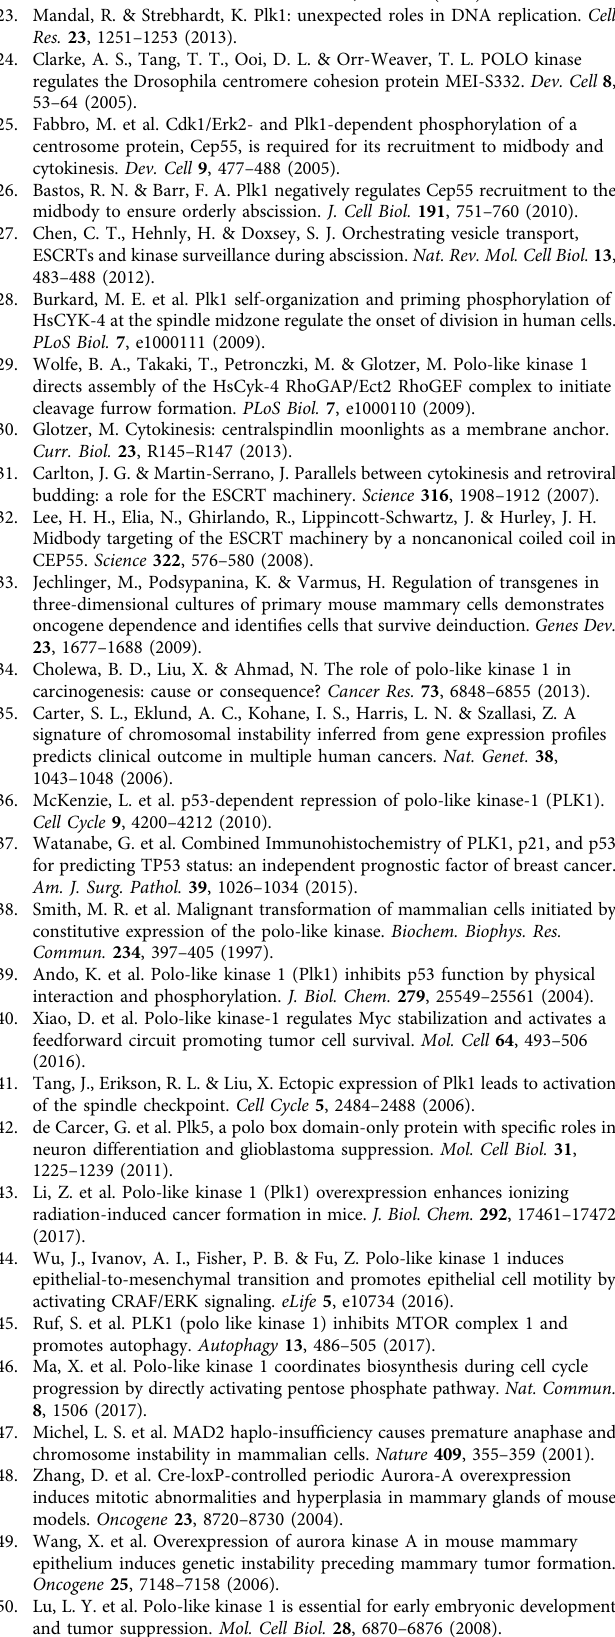
Human breast cancer data . TCGA RNA-Seq expression data and clinical data were obtained from the TCGA data portal. Copy number and mutation data were obtained from ref. 69 . PLK1 expression was normalized relative to TBP and log2 transformed. Genome doubling was estimated as previously described 70 . Survival analysis was performed using Kaplan – Meier curves and Cox proportional hazard models. Statistical analysis . GraphPad Prism 6 was utilized for all statistical testing. Control samples for in vivo mammary gland-related experiments were obtained from animals containing the transgenes but kept on a normal diet or animals lacking MMTV-rtTA but placed under a doxycycline-enriched diet